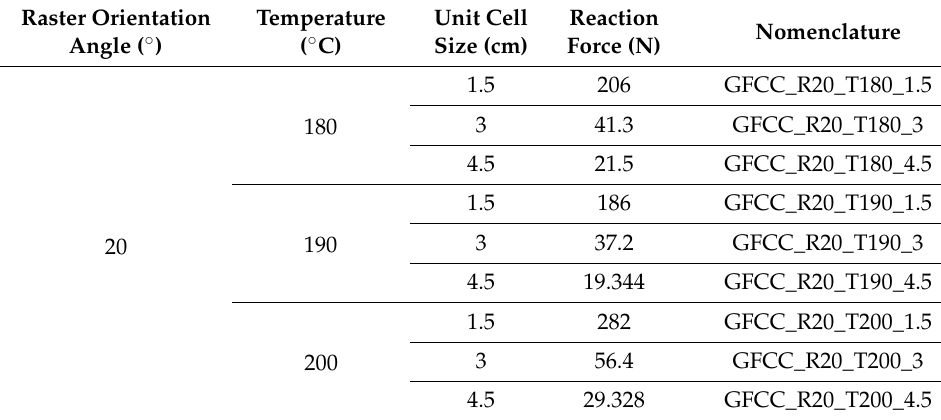
Table A3. Results obtained for